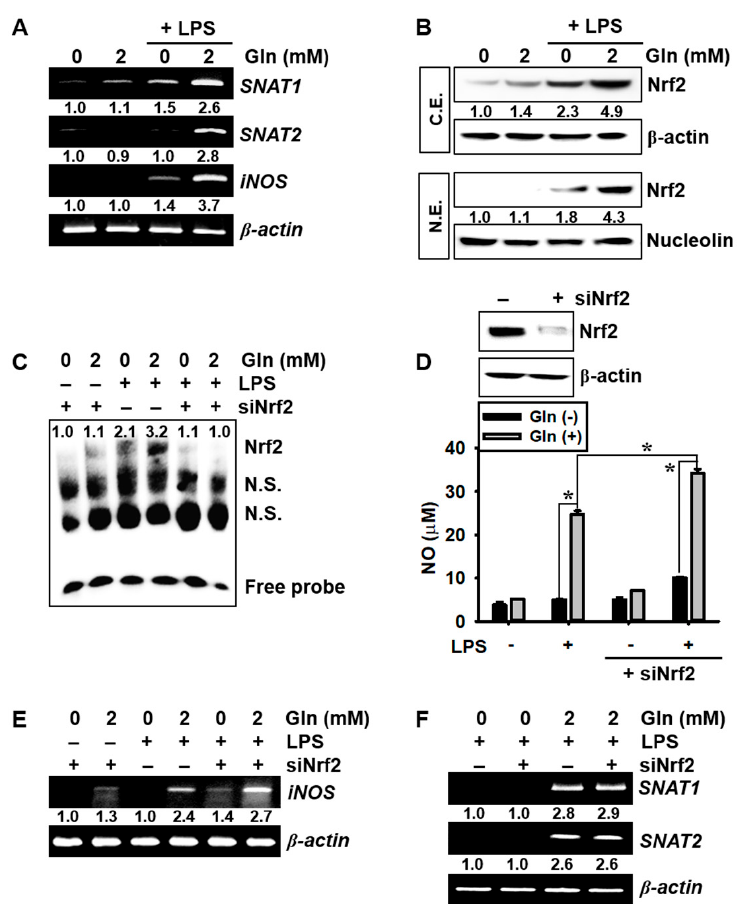
Figure 3. Glutamine (Gln) increases sodium-coupled amino acid transporters ( SNATs ) and inducible nitric oxide synthase ( iNOS ) expression as well as nitric oxide (NO) production, in the presence of lipopolysaccharide (LPS), but not nuclear factor erythroid 2-related factor 2 (Nrf2) expression. BV2 microglial cells (1 × 10 5 cells / mL) were incubated with 500 ng / mL LPS in the presence or absence of Gln. ( A ) Total RNA was isolated at 6 h and RT–PCR for SNAT1 , SNAT2 , and iNOS was performed. ( B ) Nuclear and cytosolic protein was extracted at 24 h and western blotting was performed. β -Actin and nucleolin was used as the internal control for the cytosolic and nuclear fractions, respectively. Densitometry values were expressed compared to the β -actin and nucleolin levels; shown at the bottom of each figure. ( C – F ) BV2 microglial cells were transiently transfected with Nrf2 siRNA (siNrf2) for 48 h in the presence of Gln and cultured with or without LPS under Gln-free condition or in the presence of Gln. ( C ) After LPS treatment for 30 min, nuclear extracts were prepared, and electrophoretic mobility shift assay was performed to assess the binding activity of Nrf2 on the anti-oxidant response element (ARE). N.S., No-specific binding of the probe. ( D ) After transfection of siNrf2 for 48 h, the level of Nrf2 expression was detected by western blotting ( top ). The amount of NO were determined by the Griess reaction, and a standard curve was constructed using NaNO 2 ( bottom ). ( E ) The expression of iNOS and ( F ) SNAT1 / 2 was detected at 6 h by RT–PCR. β -Actin was used as an internal control for RT–PCR. Densitometry values were expressed compared to the β -actin levels and displayed at the bottom of each figure. The results are the average of three independent experiments and are expressed as mean ± standard error of the median ( * , p < 0.01).